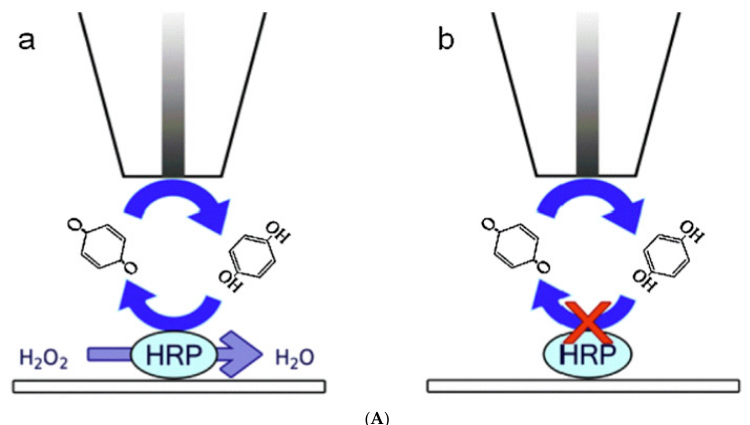
Figure 8. ( A ): Scheme of the immunosensor. ( B ): Cyclic Voltammograms reported on the left show: ( a ) CVs of OVA-immunosensor after incubation in the extract canvas, before and after the addition of glucose; ( b ) CVs of methylene blue at NEE IgY immunosensors incubated with canvas sample, before and after the addition of hydrogen peroxide. ( c ) and ( d ) show the same conditions of ( a ) and ( b) but working with the original sampled Virgin. Reproduced and reprinted with permission from